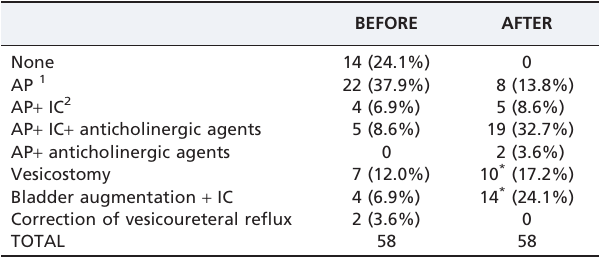
Table 1 - Therapeutic interventions for neurogenic bladder performed before and after arrival at